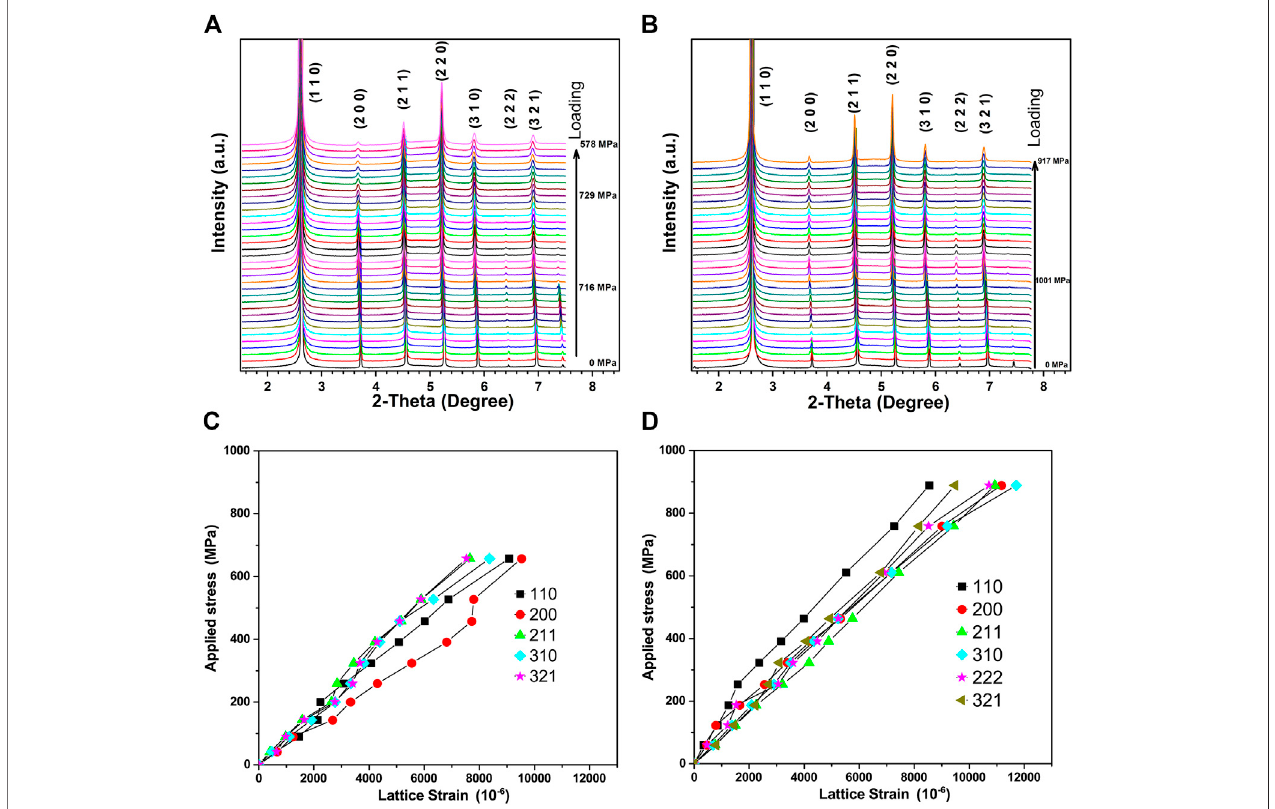
FIGURE 5 | The 1-D synchrotron X-ray diffraction pro fi les of the SST samples in the loading direction under different loadings, (A) O-0 and (B) O-1.5. Evolution of lattice strain of (C) O-0 and (D) O-1.5 as a function of applied stress during tension.